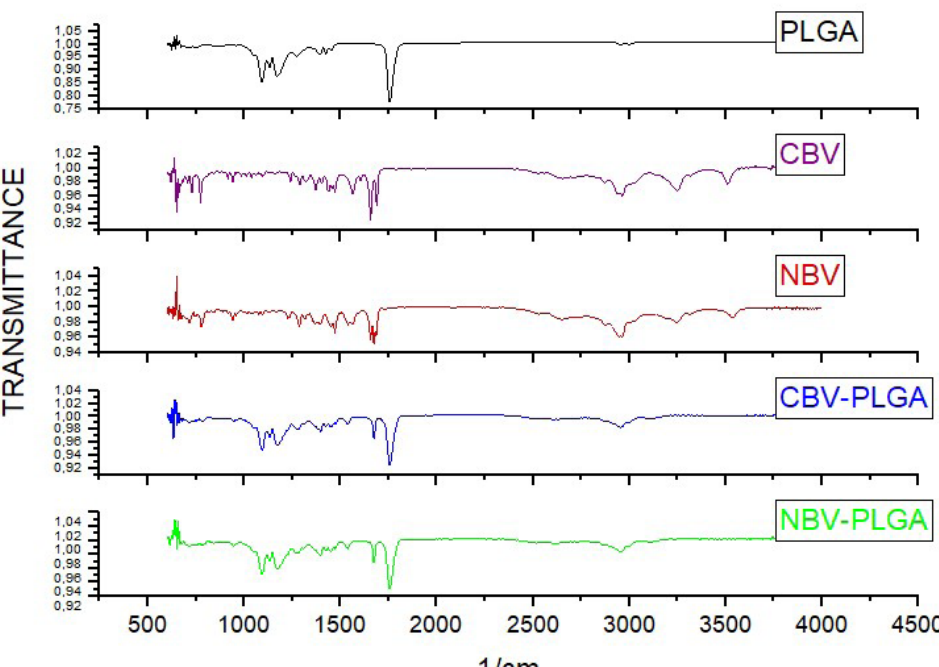
FIGURE 3 - FTIR spectra of PLGA, CBV, NBV, and lyophilized mixtures of CBV-PLGA and NBV-PLGA. The fingerprint of each molecule can be observed through the functional groups. Wavelengths from 400 to 4000 cm -1